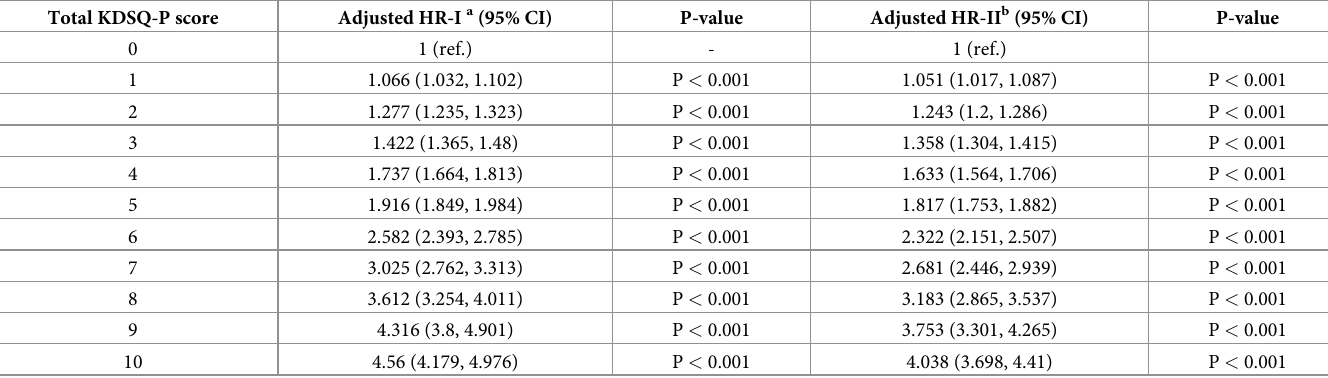
Table 3. Risk of total dementia according to severity of subjective memory complaints.